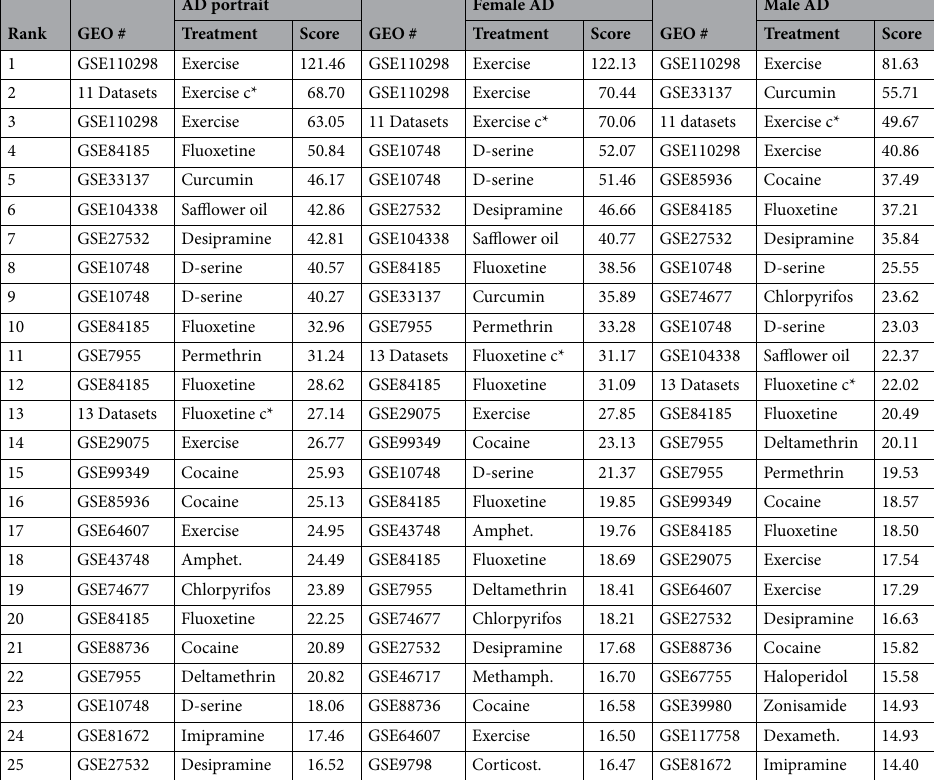
Table 1. Listing of the top 25 treatments for the AD portrait, the female AD portrait, and the male AD portrait. Additional details, including species, sex, and tissue source are provided in Supplementary Table S2. c* composite, corticost. Corticosterone, amphet. amphetamine, methamph. methamphetamine, dexameth.